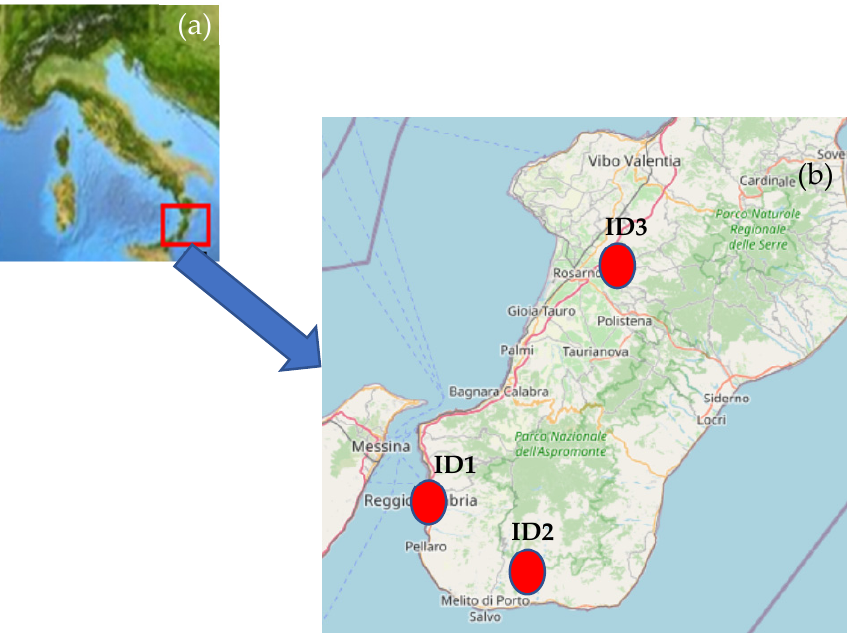
Figure 1. The map of the sampling area ( a ), with the site IDs (1–3) indicated ( b ). Table 1. The IDs and GPS coordinates of the sampling sites.